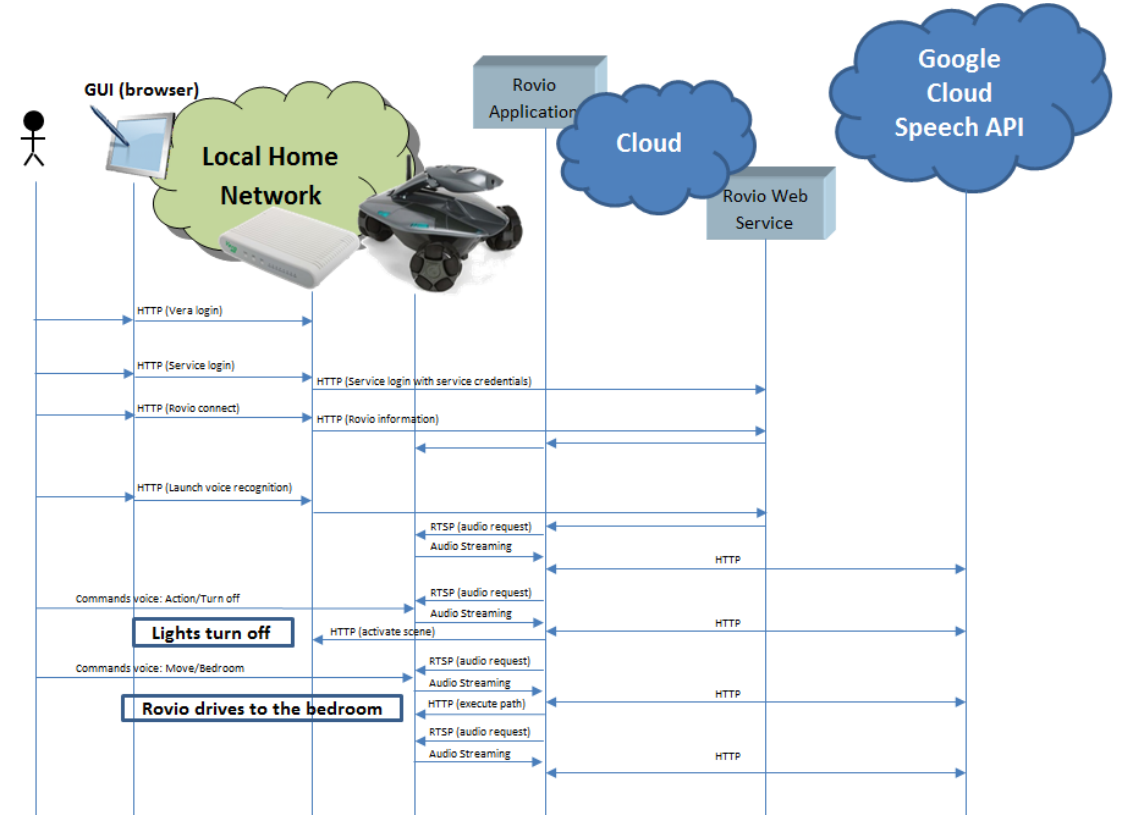
Figure 5. Messages exchange for Rovio and Vera router